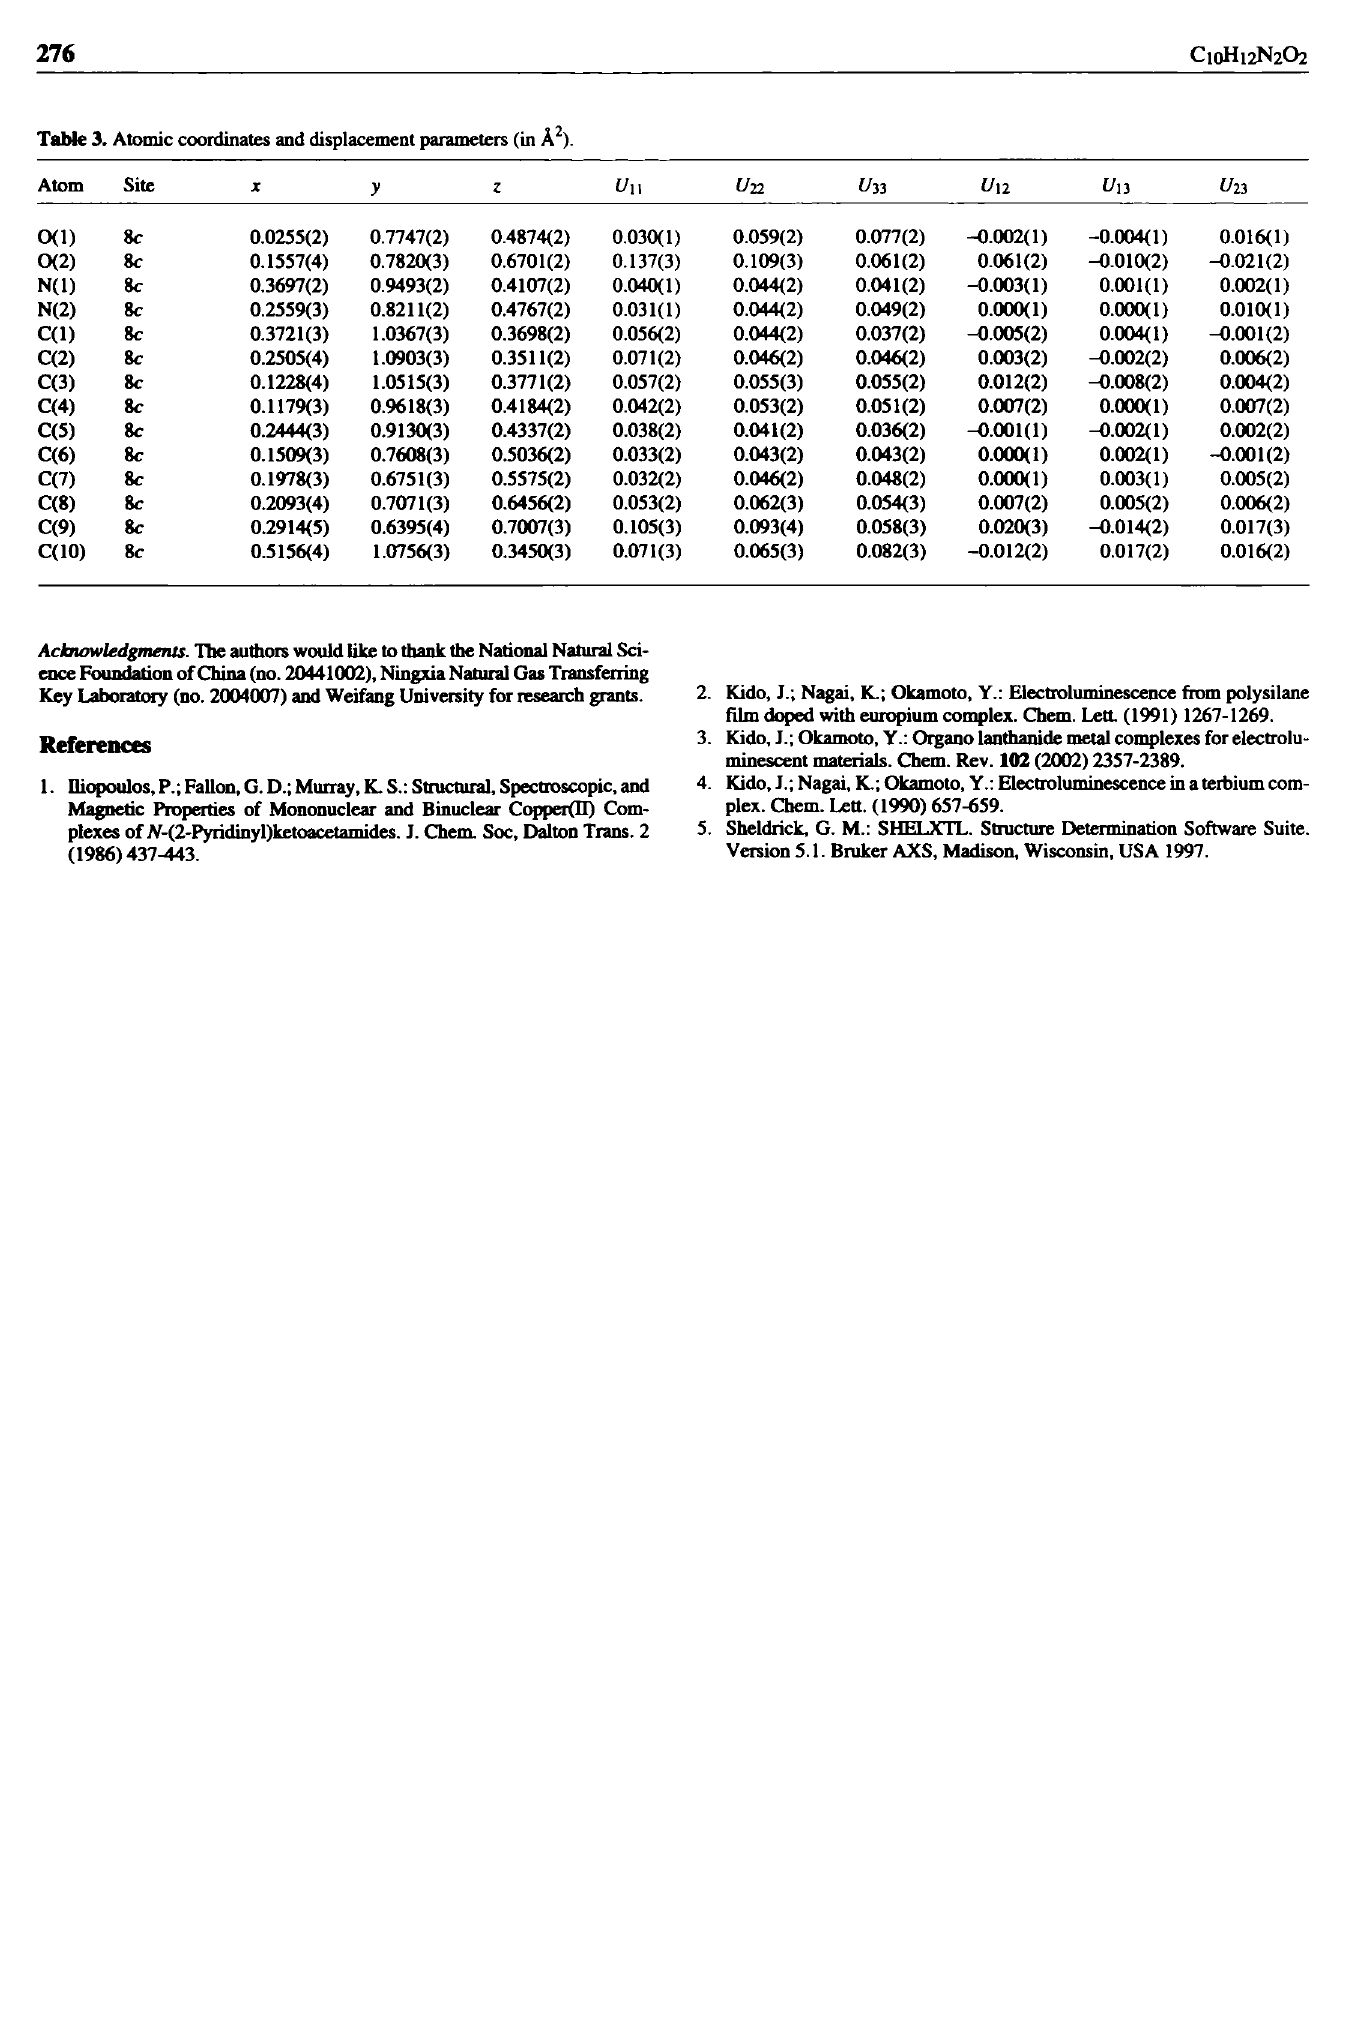
Table 3. Atomic coordinates and displacement parameters (in A 2